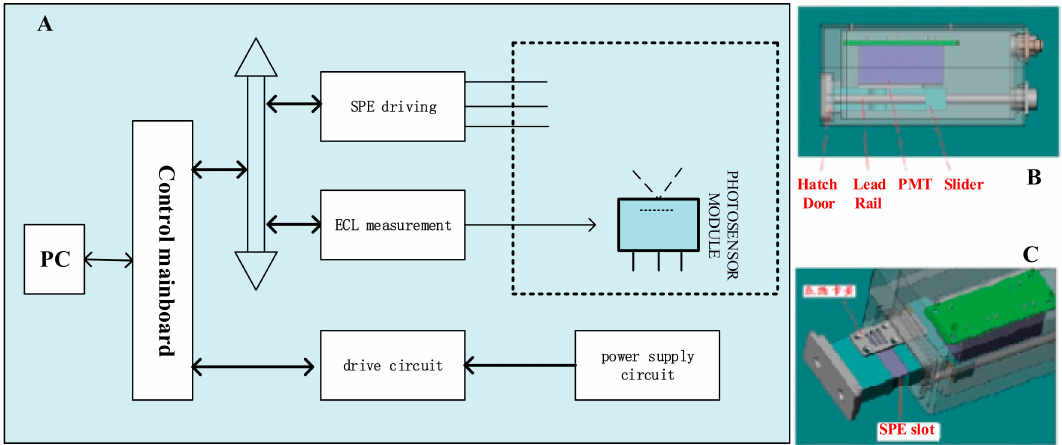
Figure 2. Overall structure of portable ECL detection platform: ( A ) the overall schematic diagram and main modules of the sensor including SPE, PMT, control mainboard, drive and power supply circuit; ( B ) the main mechanical structure of sensor including hatch door, lead rail, PMT and slider, and the whole shape is a small cube; and( C ) a slot for clamping the SPE, which can pass in and out along the lead rail with the assistance of the